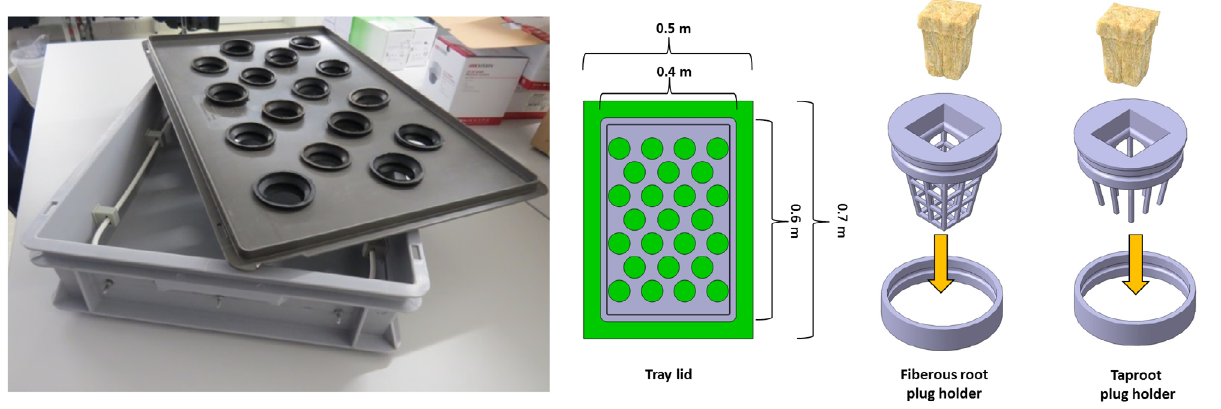
Figure 2: Left: Standard tray lid (0.4x0.6 m) for plant accommodation within the EDEN lab; Middle: The standard tray lid has a 0.05 m buffer surrounding the tray for an effective cultivation area of 0.35 m² (0.5x0.7 m). Right: Graphical visualisation of the seed/ plant plug holder for different types of root